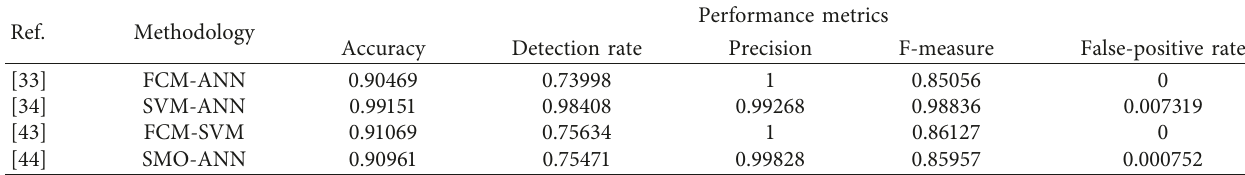
Table 14: Comparison of various methodologies based on different performance metrics for DoS attack. Ref.